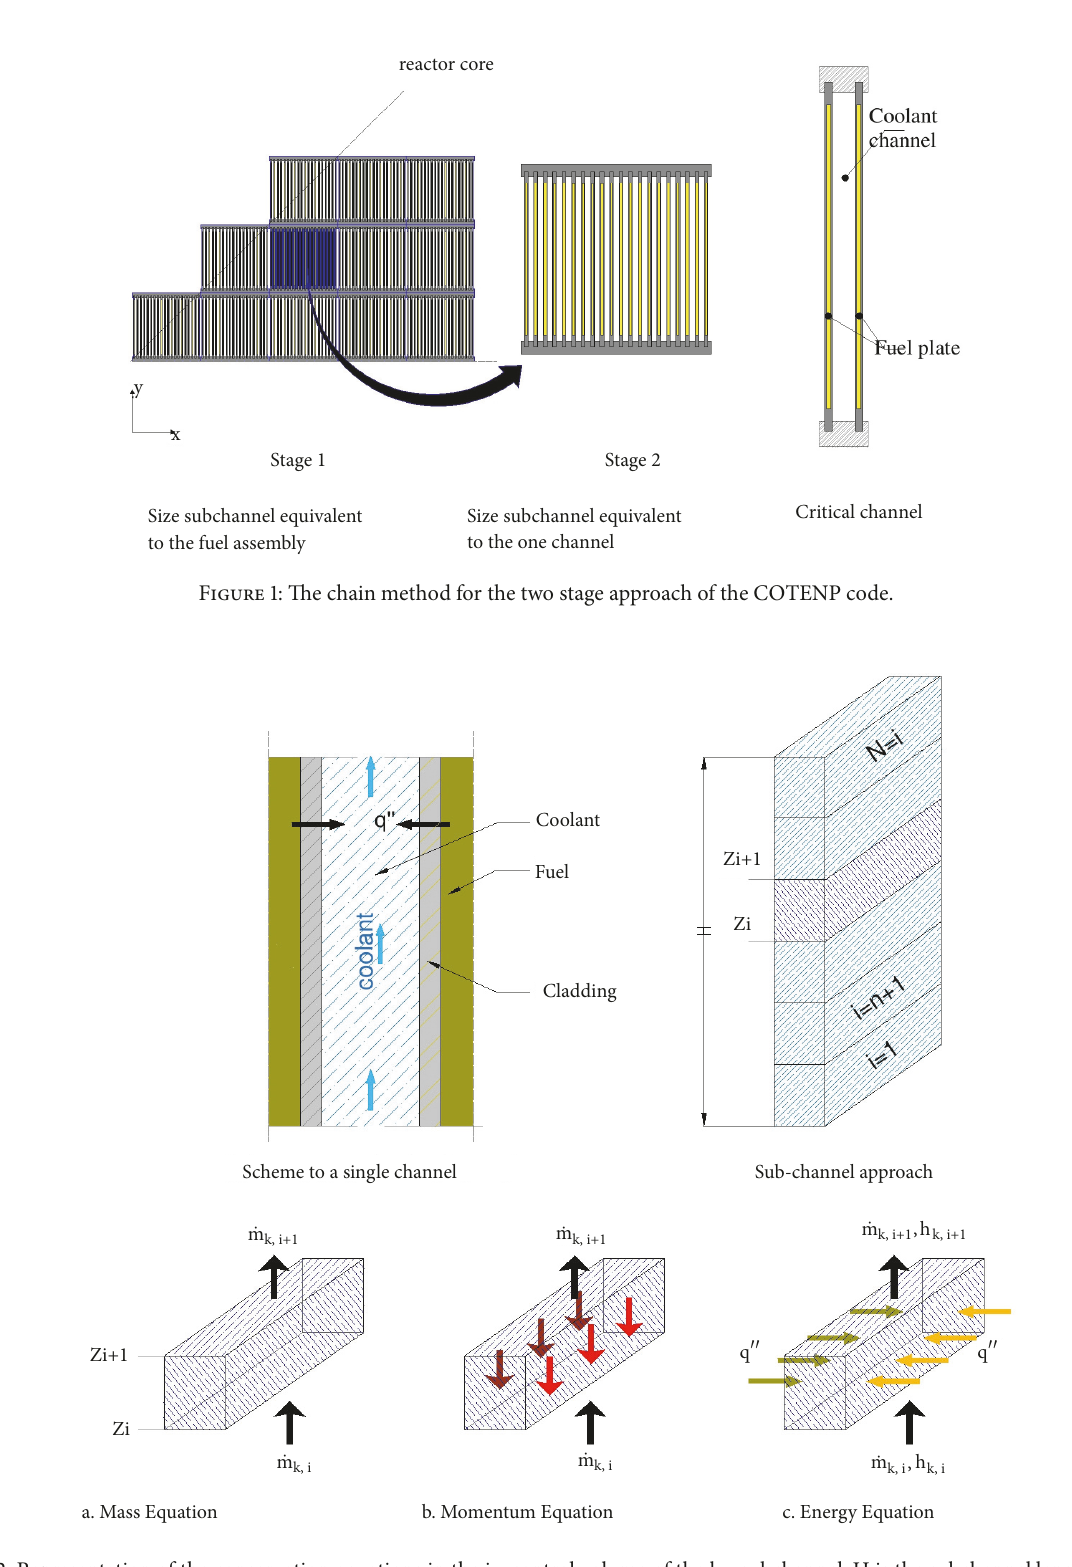
Figure 2: Representation of the conservation equations in the i th control volume of the k th subchannel. H is the subchannel length, L is the plate side length, and d is the distance between plates or coolant channel